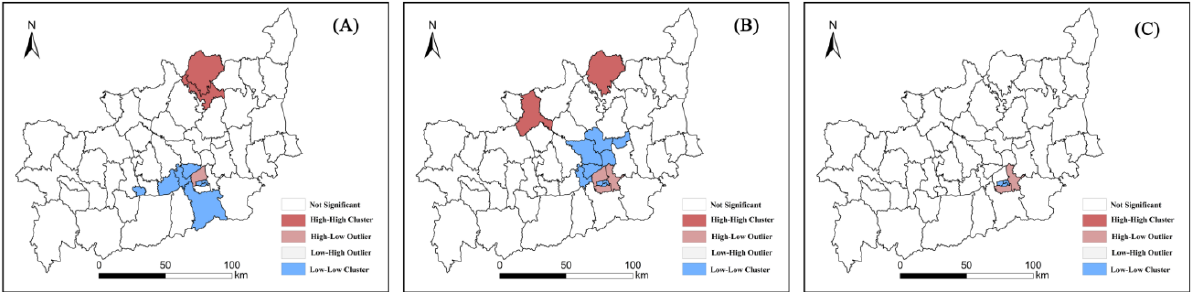
Figure 6. The LISA cluster distribution of NGPR: ( A ) 2000, ( B ) 2010, and ( C ) 2019.